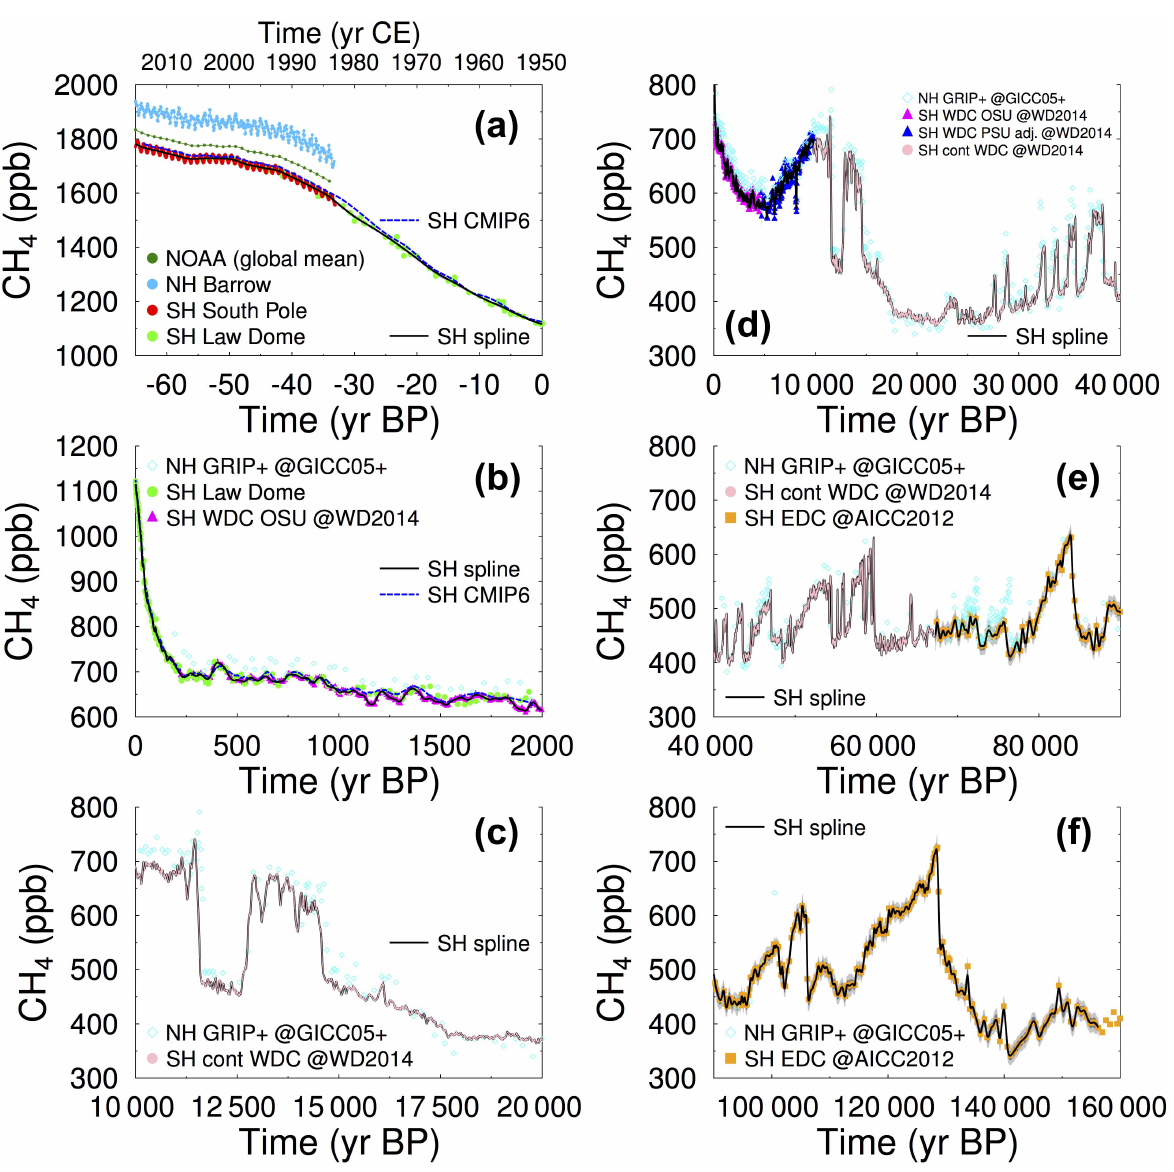
Figure 4. Details of the southern hemispheric CH 4 spline. Light and dark grey bands around the spline represents ± 1 σ and ± 2 σ , respec- tively. (a) Instrumental times (1950–2016CE); (b) 0–2000BP; (c) Termination I; (d) 0–40kyrBP without the Law Dome data showing the anthropogenic rise; (e) 40–90kyrBP; (f) 90–160kyrBP. Hemispheric origin of data is indicated by NH (north) and SH (south). WDC PSU data are adjusted by + 9 . 9ppb. GRIP+: Greenland composite; GICC05+: GICC05 model extended. See text for details. Dashed line labelled CMIP6 in panels (a) and (b) is the compiled CH 4 record to be used in CMIP6 experiments for the last 2kyr (Meinshausen et al.,